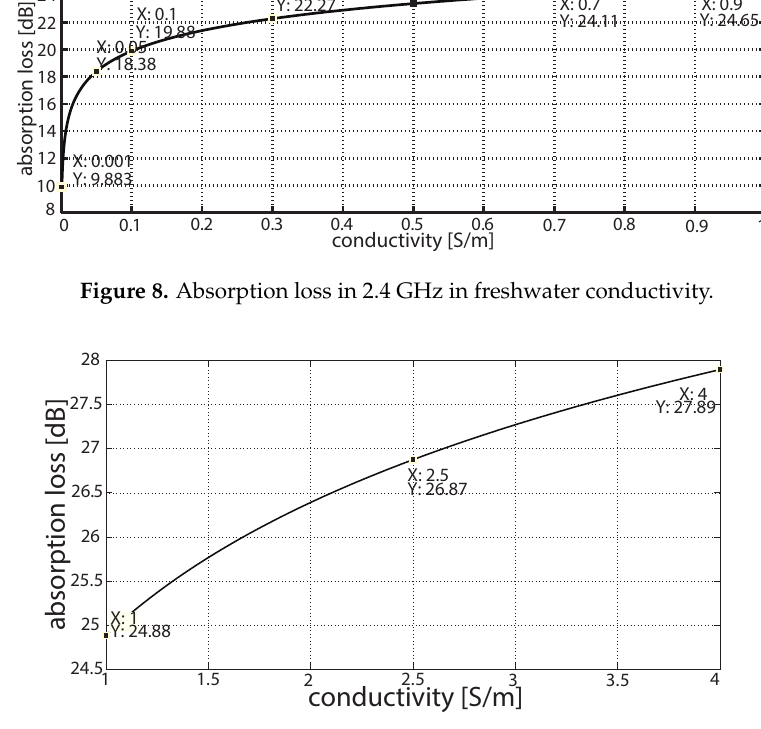
Figure 9. Absorption loss in 2.4 GHz in river water and seawater